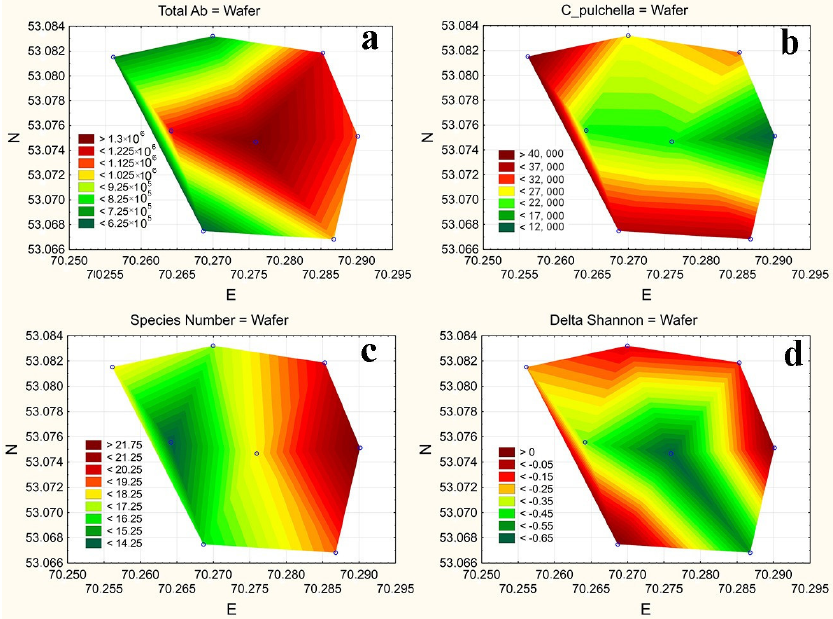
Figure 4. Spatial distribution of zooplankton abundance ( a ), abundance of C. pulchella ( b ), number of species ( c ), values of Δ -Shannon ( d ) over the water area of the Borovoe Lake, 2019.